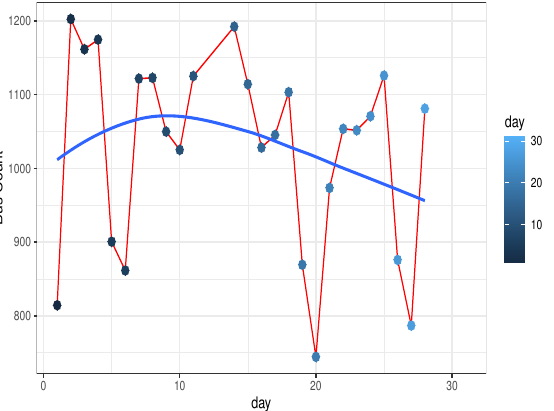
Figure 4. The average volume of the bus traffic count per day in the sparse